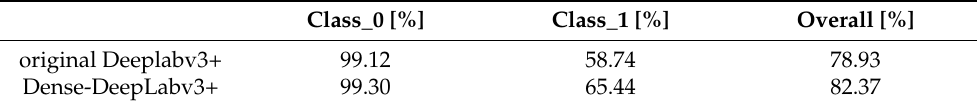
Table 2. Comparison of original DeepLabv3+ and Dense-DeepLabv3+